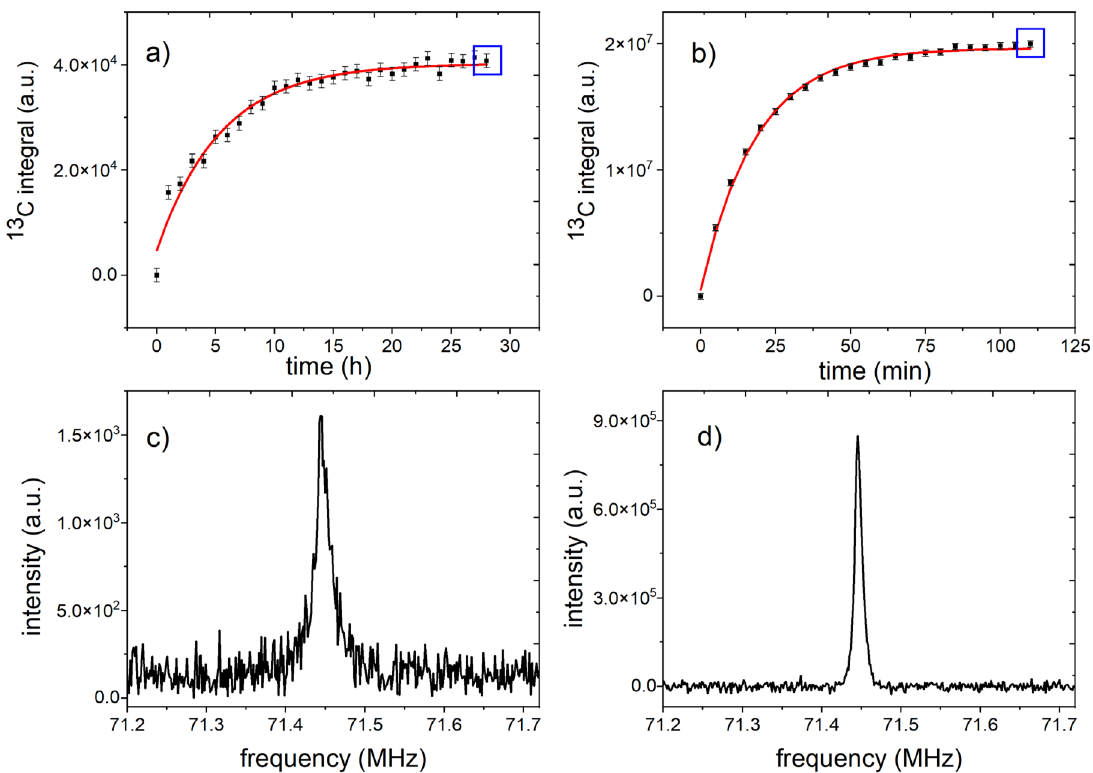
Figure 5. Quantification of solid-state polarization. Solid-state, 13 C-NMR signals of 14 M 1- 13 C pyruvic acid mixed with 30 mM radical (112.3 mg total sample weight) monitored with low flip angle excitations ( α ~ 0.32°, NS = NX = 256, TR = 1 h (a) or TR = 5 min (b)) while reaching thermal equilibrium at ≈ 1.4 K and 6.7 T ( a ) and during DNP ( b ). Blue squares indicate the spectra shown below ( c , d ). By fitting a mono-exponential recovery function (Eq. 5) to the polarization build up without µW ( a ) and with µW ( b ) and correcting for the RF excitations (Eq. 6), a solid-state relaxation T ss 1 ≈ ( 5.45 ± 0.44 ) h , signal at thermal equilibrium = signal S ssTP 4.07 · 10 4 ± 0.1 · 10 4 , DNP build-up time T DNP = (18.396 ± 0.49) min and equilibrium signal inf (cid:31) (cid:30) 2.0 · 10 7 ± 0.2 · 10 6 ) a.u. were obtained (note that this build up is faster than for the standard sample). S ssDNP inf = ( The polarization of the spectrum acquired after 110 min DNP was quantified to P obs , ssDNP (110 min) = S ssDNP (110 min) P TP / S ssTP inf ≈ 64%. Without RF excitations the expected steady state signal is estimated to be P TP / S ssTP P ssDNP S ssDNP inf = inf inf ≈ 61% The spectra ( c ) and ( d ) are the last measured thermal recovery and DNP spectra (marked on ( a ) and ( b ) with blue rectangles). The first six datapoints in ( a ) were neglected for the fit because of very low